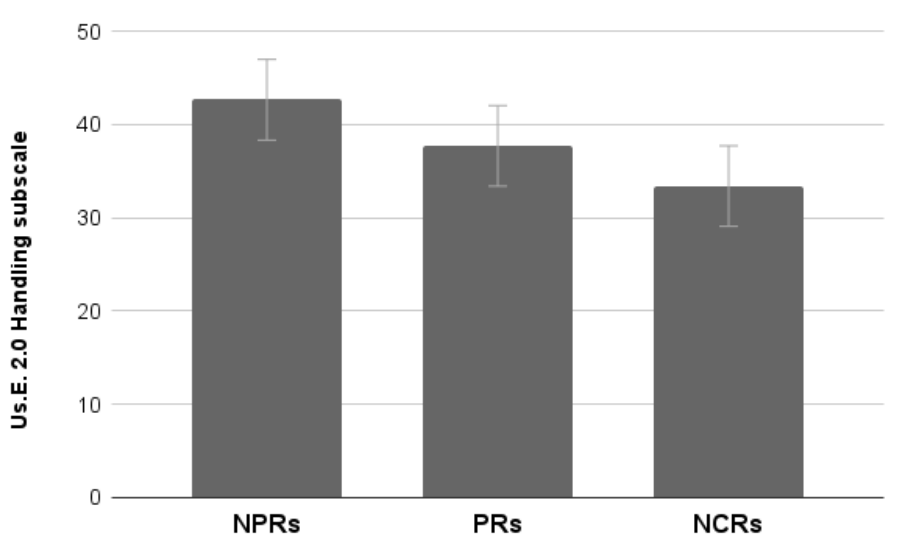
Figure 15. Us.E. 2.0 Handling subscale score by Group (NPRs vs. PRs vs. NCRs). Error bars denote 0.95 confidence intervals.